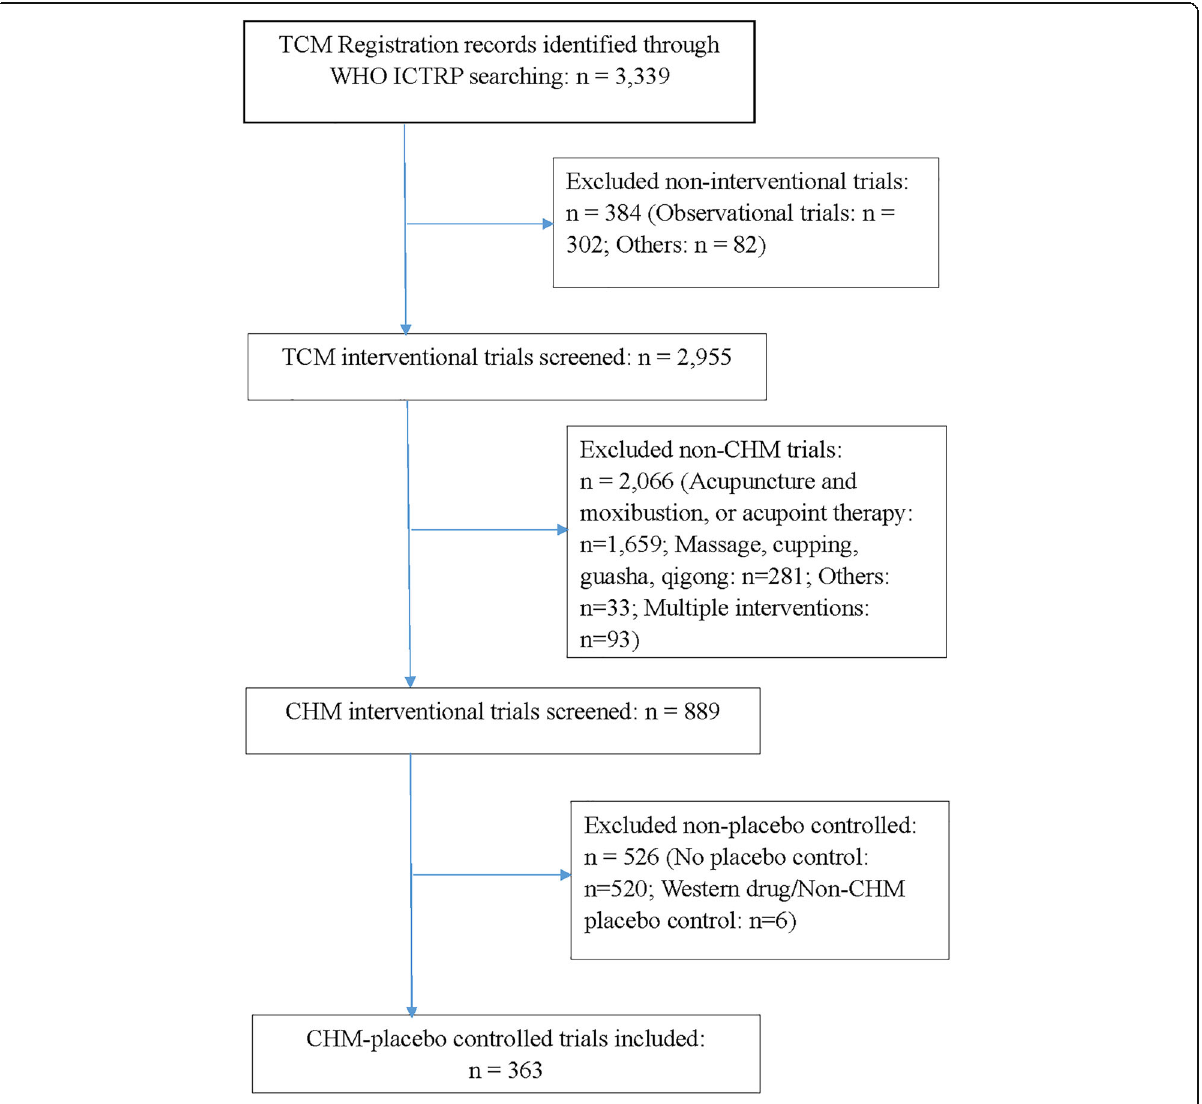
Fig. 1 Flow chart of data identified, included and